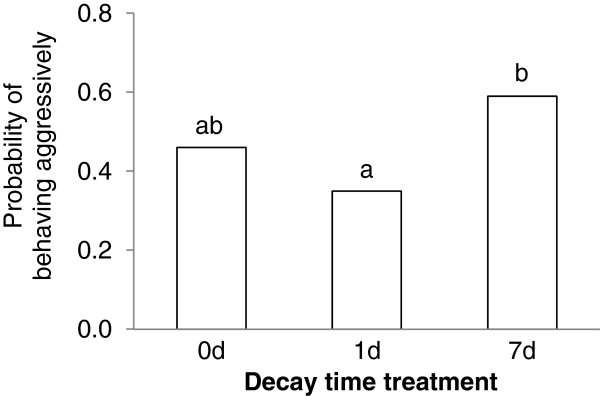
The likelihood of behaving aggressively for the focal individuals assigned to different decay-time treatments. Bars labelled with different letters differ significantly in the likelihood (P < 0.05, likelihood ratio χ2 test).